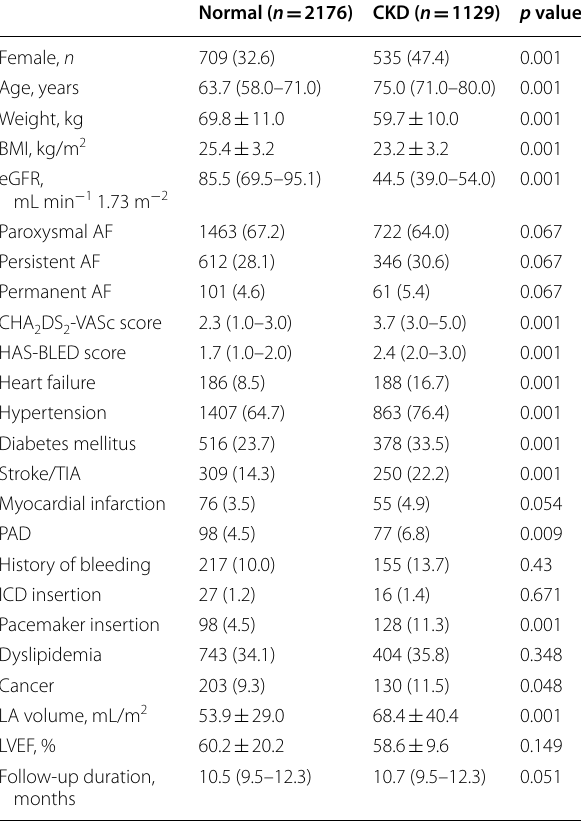
Table 1 Baseline characteristics of